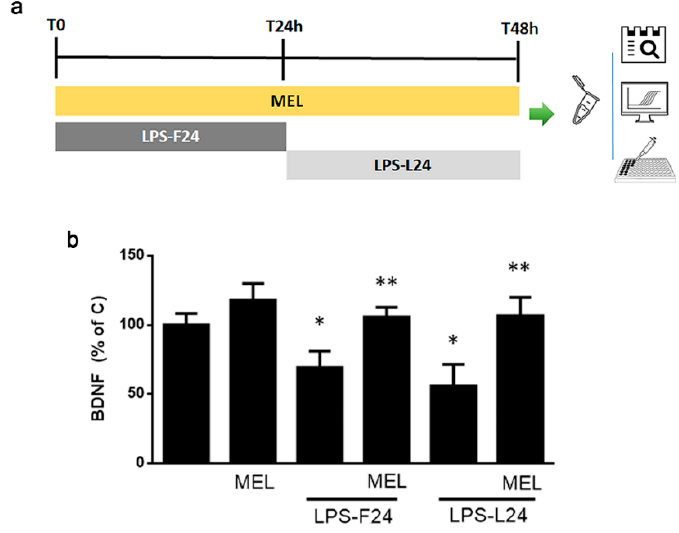
Figure 5. Polarization of HMC3 microglia. In ( a ), the experimental paradigm used is reported. MEL (1 µ M) was always added for 48 h. When in combination with LPS (1 µ g/mL), two different settings were used: LPS was added for the first 24 h, followed by removal and further incubation for 24 h (LPS-F24); alternatively, cells were incubated for 24 h prior to addition of LPS for the last 24 h (LPS-L24). In ( b ), BDNF release evaluated by ELISA. Data are means ± SEM of n = 3 experiments. * p < 0.05 vs. C and ** p < 0.05 vs. respective LPS-treated by one-way ANOVA followed by Fisher-LSD test for significance.